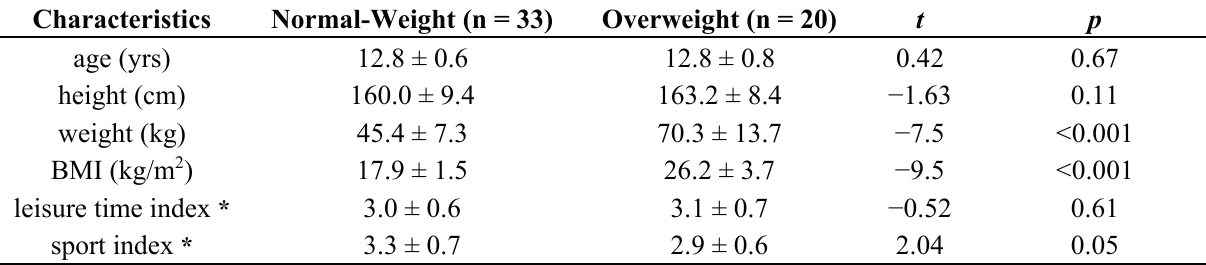
Table 1. Descriptive characteristics of participants.